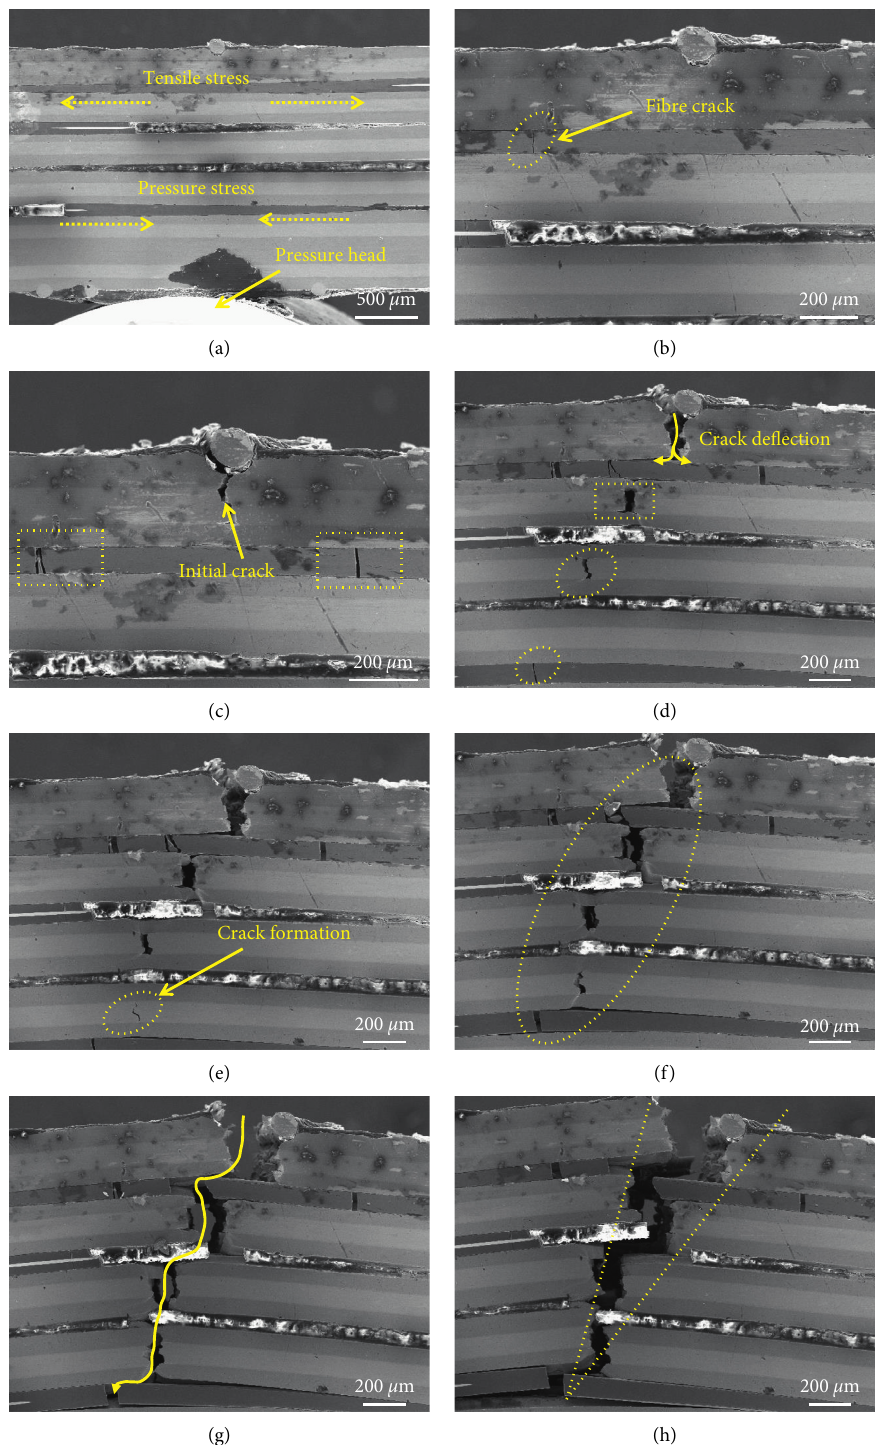
Figure 10: Scanning electron microscopy (SEM) micrographs of in-situ three-point bending test of the composite. (a) Initial state of loading; (b) initial brittle cracking of fiber; (c–g) generation and spreading of cracks in the composite; (h) failure state of the